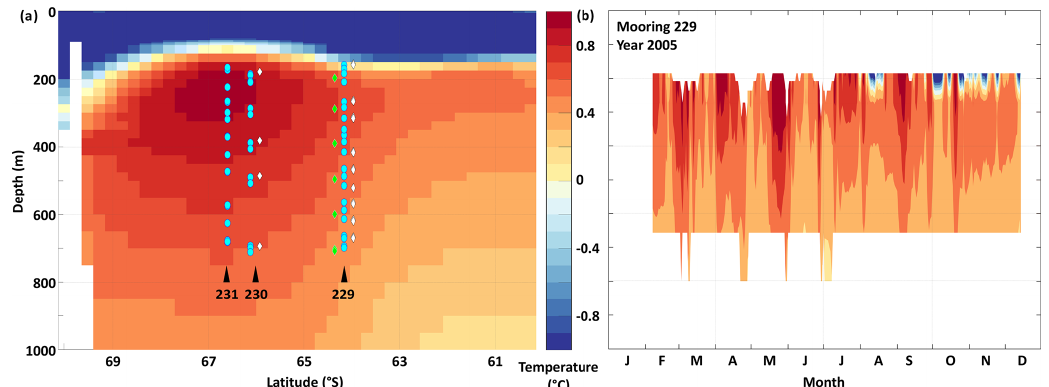
Figure 7. (a) Climatological temperature along the Prime Meridian, from Locarnini et al. (2018), showing the comparatively warm Circum- polar Deep Water in red. For each mooring line (229, 230, and 231), the symbols indicate the depth of the mooring temperature sensors during deployments that coincided with polynya events: white diamonds for 1999 and 2000; cyan circles for 2004 and 2005; and green diamonds for 2016. The latitude shift between deployments of the same mooring is for readability only. The salinity section is available in Fig. B3. (b) On the same vertical axis (depth from 0 to 1000m), time series of daily median temperature as recorded by mooring 229 in 2005 are